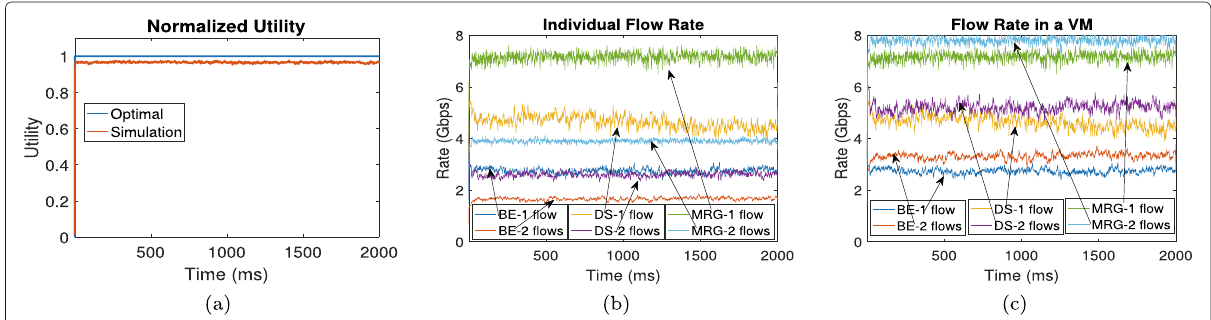
Fig. 5 Normalized utility and rate allocation for half hosts having one flow and half hosts having two flows : ( a ) Normalized utility; ( b ) Average flow rate; and ( c ) Total per VM